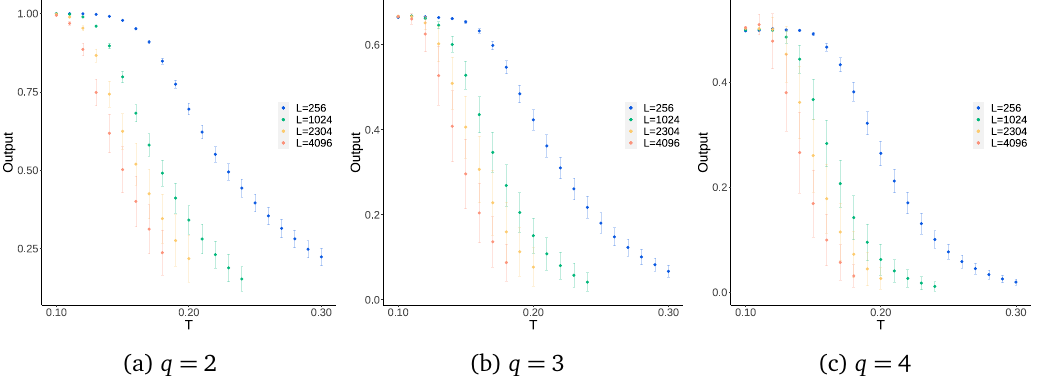
Figure 15: The relationship between temperature and the average output of an en- semble of 10 independently trained ANNs – training with simplified data, and testing with MC data of the one-dimensional ferromagnetic q -state Potts model. The error bars shown are 99.7% confidence intervals of the ensemble